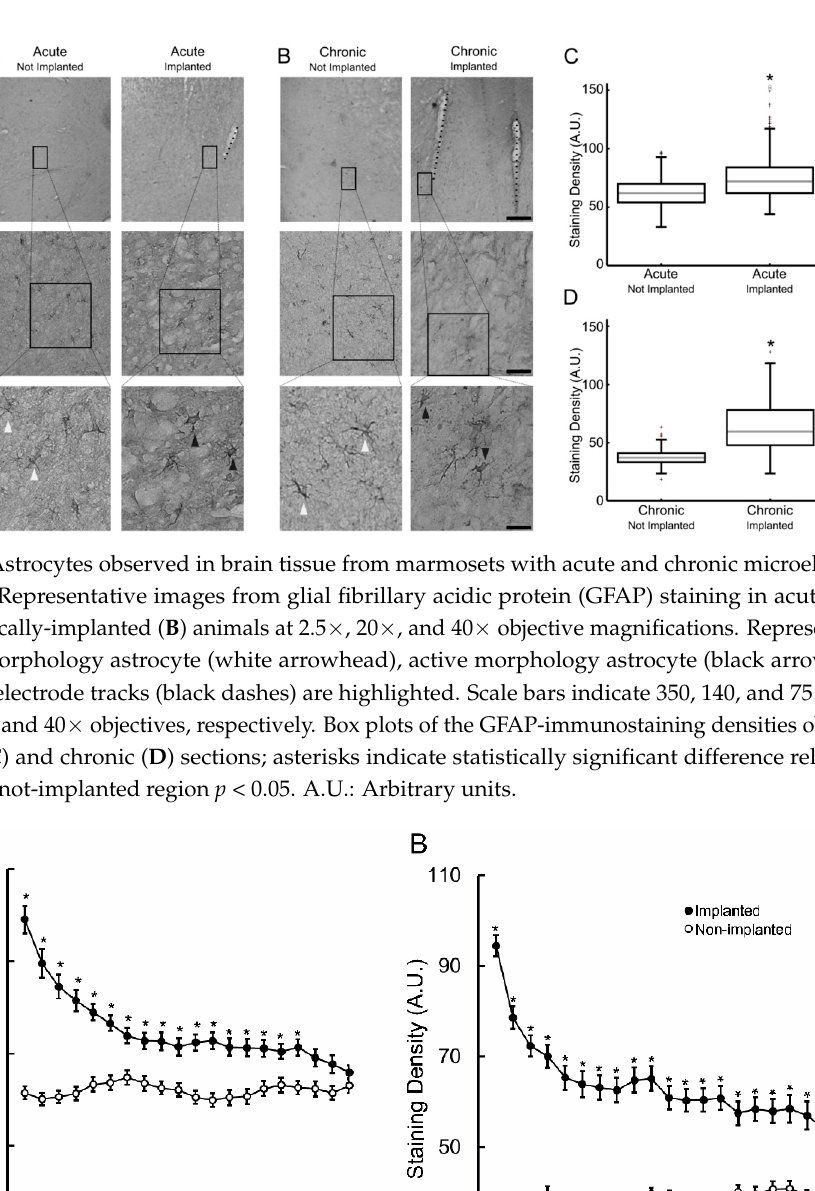
Figure 3. Normalized GFAP-immunostaining density (mean ± SEM) within 1000 µm from the microelectrode track in chronically- and acutely-implanted marmosets. Asterisks indicate statistically significant difference between acute vs chronic regions of the same distance from microelectrodes implants p < 0.05.